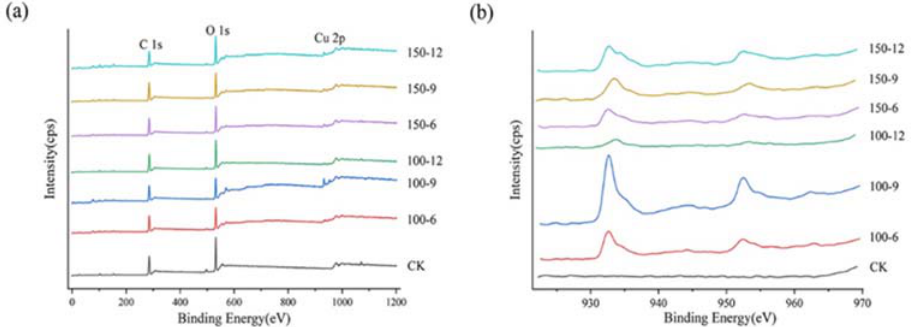
Figure 5. ( a ) The complete XPS spectra of the bamboo fiber bundle and samples after magnetron sputtering. ( b ) The high-resolution XPS spectrum of copper 2p.